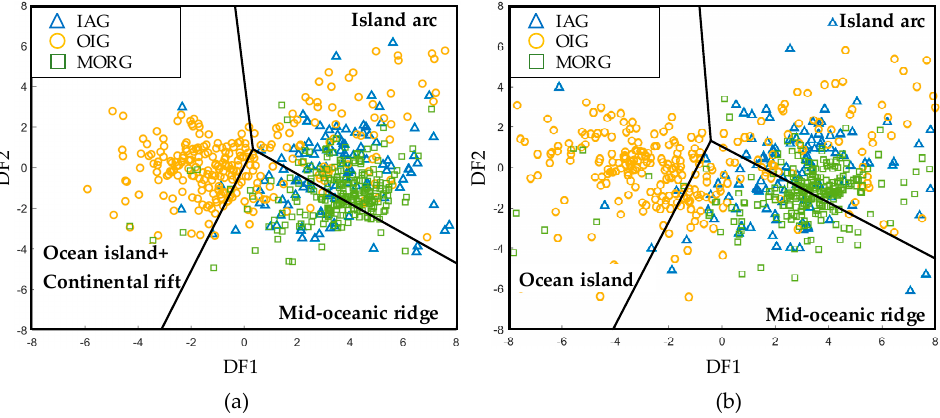
Figure 23. Basic and ultrabasic discrimination diagrams [61]. In ( a ), the DF1 = − 0.6611 × ln (Nb/(TiO 2 ) adj ) + 2.2926 × ln(V/(TiO 2 ) adj ) + 1.6774 × ln (Y/(TiO 2 ) adj ) +1.0916 × ln (Zr/(TiO 2 ) adj ) + 21.3603, + 2.2926 × ln(V / (TiO + 1.6774 × ln (Y / (TiO + 1.0916 × ln (Zr / (TiO + 21.3603, and the 2 ) adj ) 2 ) adj ) 2 ) adj ) and the DF2 = 0.4702 × ln (Nb/(TiO 2 ) adj ) + 3.7649 × ln (V/(TiO 2 ) adj ) − 3.911 × ln (Y/(TiO 2 ) adj ) + 2.2697 × ln DF2 = 0.4702 × ln (Nb / (TiO 2 ) adj ) + 3.7649 × ln (V / (TiO 2 ) adj ) − 3.911 × ln (Y / (TiO 2 ) adj ) + 2.2697 × ln (Zr/(TiO 2 ) adj ) + 4.8487; in ( b ), DF1 = − 0.2646 × ln(Nb/(TiO 2 ) adj ) + 2.0491 × ln(V/TiO 2 ) adj ) + 3.4565 × (Zr / (TiO 2 ) adj ) + 4.8487; in ( b ), DF1 = − 0.2646 × ln(Nb / (TiO 2 ) adj ) + 2.0491 × ln(V / TiO 2 ) adj ) + 3.4565 ln(Y/TiO 2 ) adj ) + 0.8573 × ln(Zr/(TiO 2 ) adj ) + 32.9472, DF2 = 0.01874 × ln(Nb/(TiO 2 ) adj ) + 4.0937 × + 0.8573 × ln(Zr / (TiO + 32.9472, DF2 = 0.01874 × ln(Nb / (TiO + 4.0937 × × ln(Y / TiO ln(V/(TiO 2 ) adj ) – 4.8550 × ln(Y/(TiO 2 ) adj ) + 2.9900 × ln(Zr/(TiO 2 ) adj ) + 0.1995. The subscript adj means 2 ) adj ) 2 ) adj ) 2 ) adj ) ln(V / (TiO 2 ) adj ) – 4.8550 × ln(Y / (TiO 2 ) adj ) + 2.9900 × ln(Zr / (TiO 2 ) adj ) + 0.1995. The subscript adj means adjust. The adjustment of the oxides refers to [68]. adjust. The adjustment of the oxides refers to